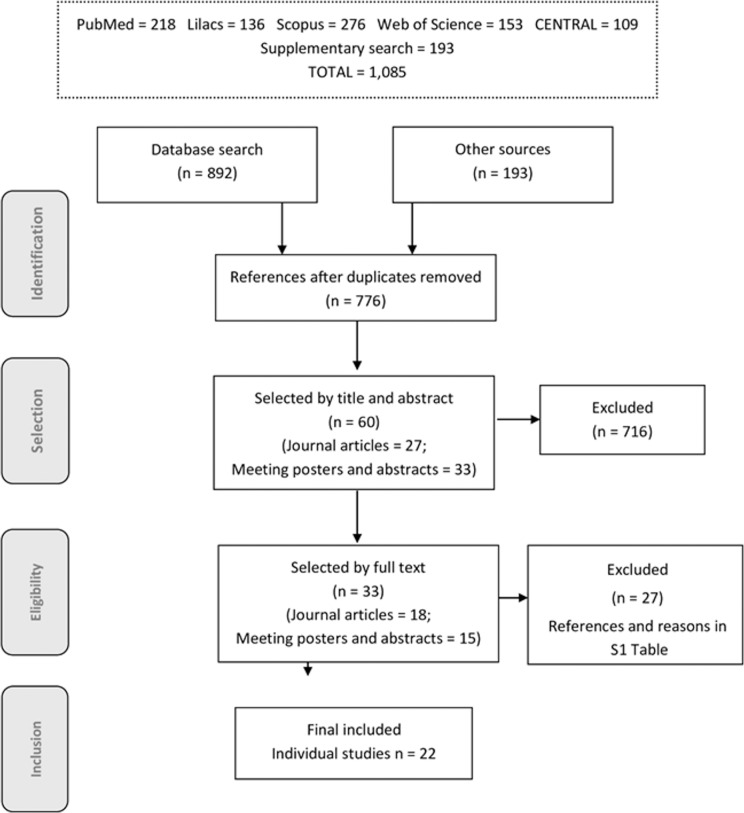
Flowchart: process of study selection.